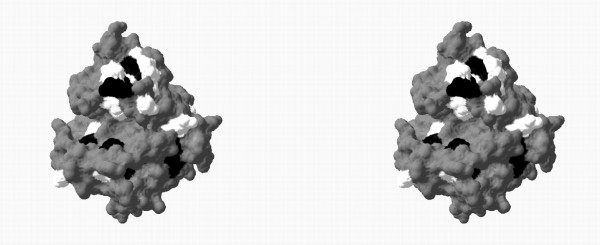
Comparative mapping of primary variable determinant positions. Primary variable determinant positions for all the studied protein family (lichenases and laminarinases) are shown in white and black. White positions are variable determinant amino acids both for lichenases and laminarinases, while black positions are primary variable determinant positions specific for laminarinases. This figure is a cross-eyed stereogram.